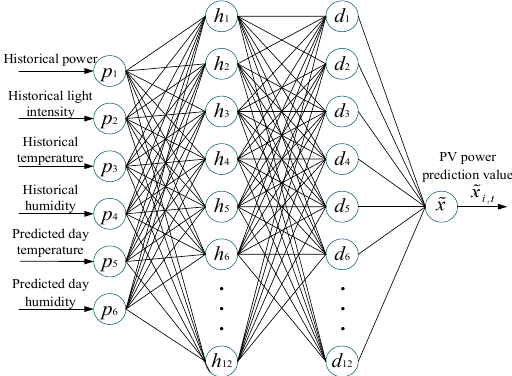
† x  is is i , t , i t